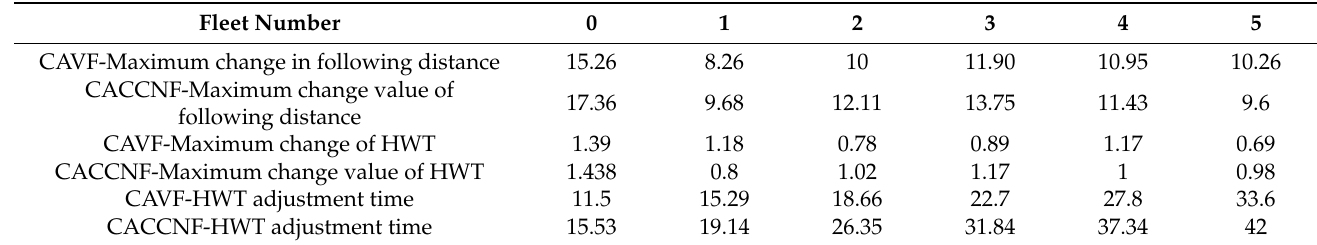
Table 5. Poor adjustment of follow-up distance and HWT of CAVF and CACCNF teams.